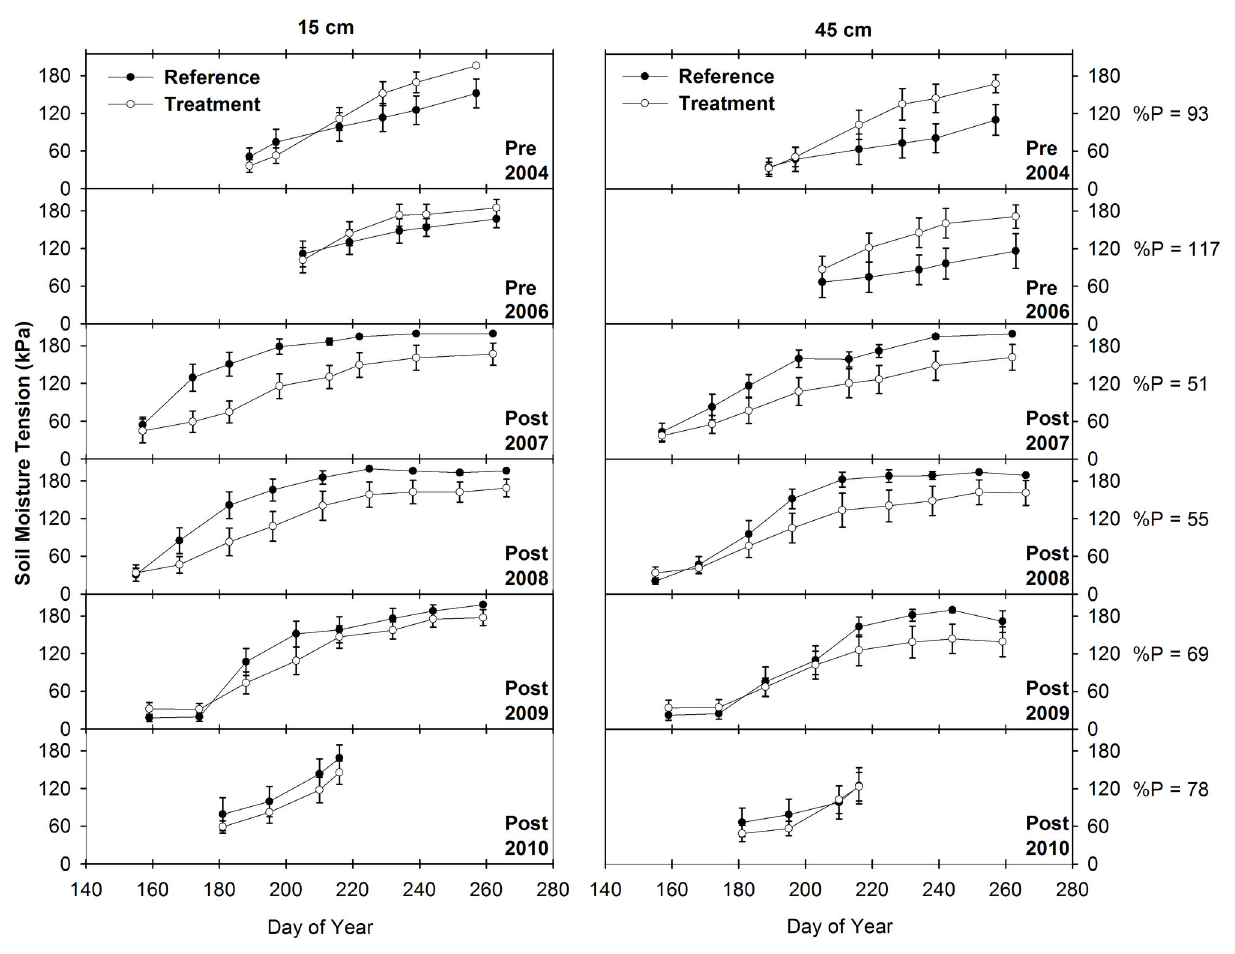
Figure 10. Mean and standard error of soil moisture at the Bailey Creek reference and treatment transects. Measurements were made at the 15 and 45 cm depths. % P = percent of mean annual precipitation. Lower values of soil moisture tension correspond to wetter soils.